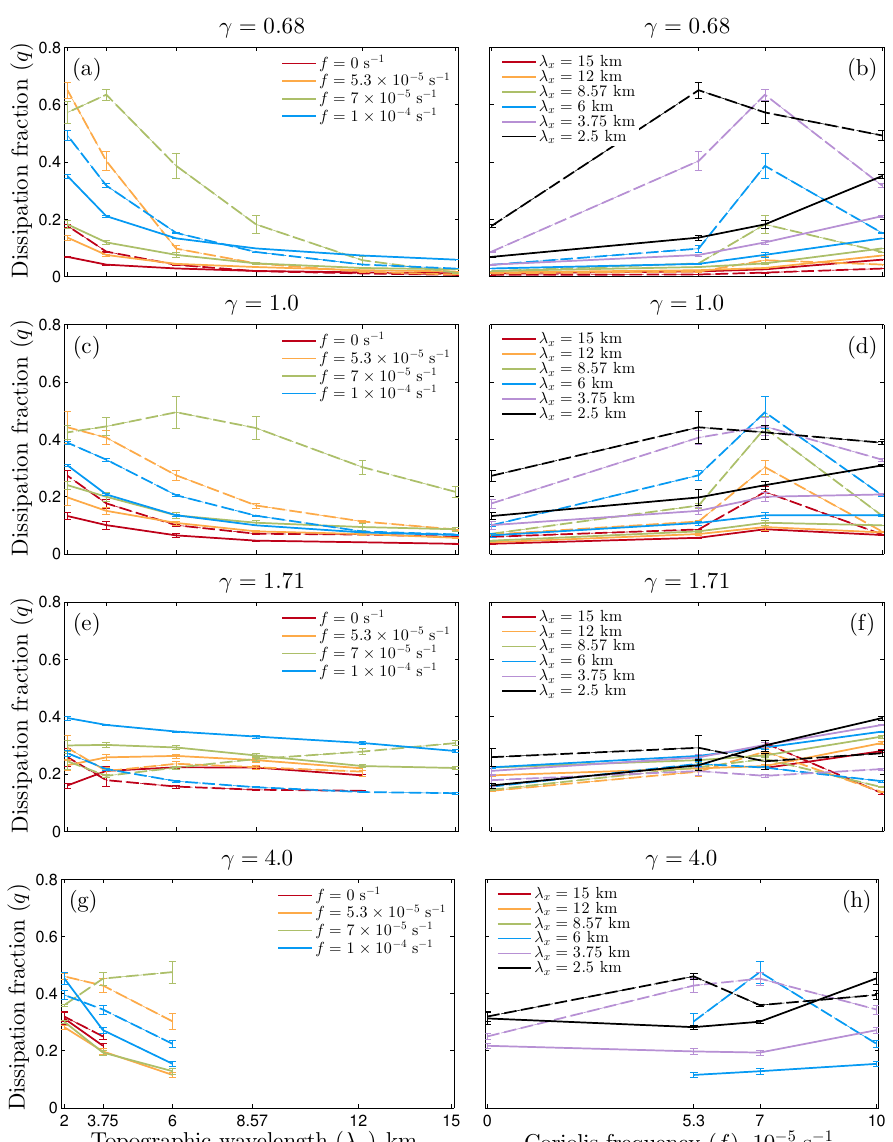
Figure 10. Dissipation fraction ( q ) for two-dimensional simulations and its errors ( 2 σ mean ) plotted against λ x (km) (lefthand column) and f (10 − 5 s − 1 ) (righthand column), for four different values of γ : (a, b) γ = 0.68, (c, d) γ = 1.0, (e, f) γ = 1.71, (g, h) γ = 4.0. q from 0–50 m above the bottom (solid lines) represents the dissipation fraction within the bottom boundary layer (bbl) near the topography, and q from 50–2000 m (dashed lines) above the bottom represents the dissipation fraction above the bbl. Only data from experiments with peak-to-trough topographic heights ≤ 1000 m are